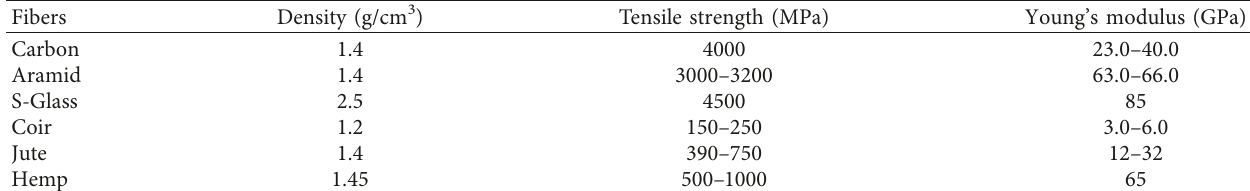
Table 7: Mechanical properties of natural and synthetic fibers comparatively